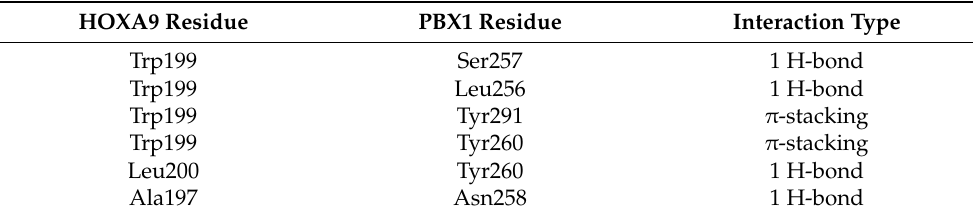
Table 1. The most frequent interactions and the related involved residues for HOXA9 hexapeptide 196-AANWLH-201 and PBX1 homeodomain proteins retrieved from MD frames clustering. HOXA9 Residue PBX1